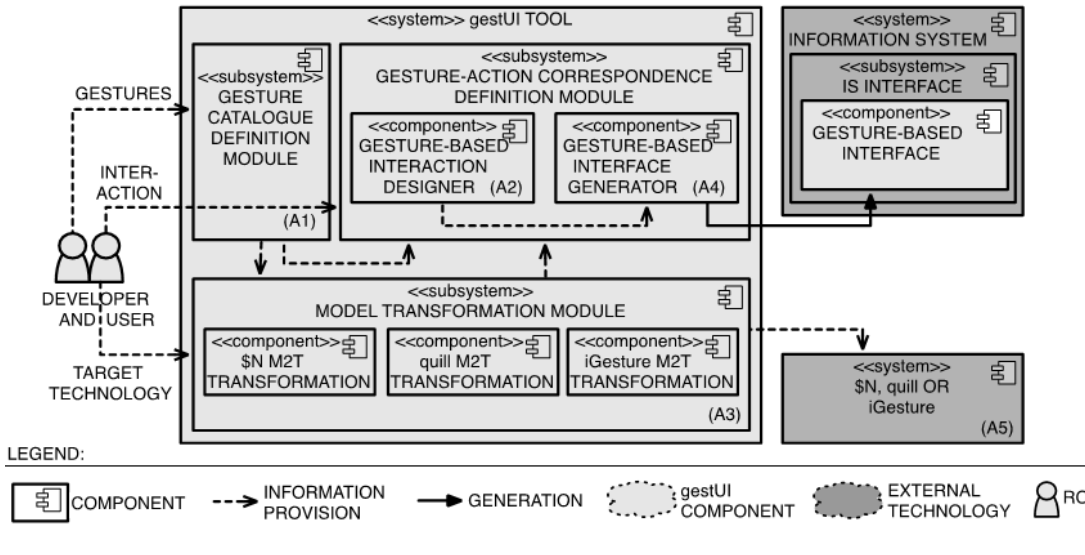
Figure 6 . gestUI tool overview